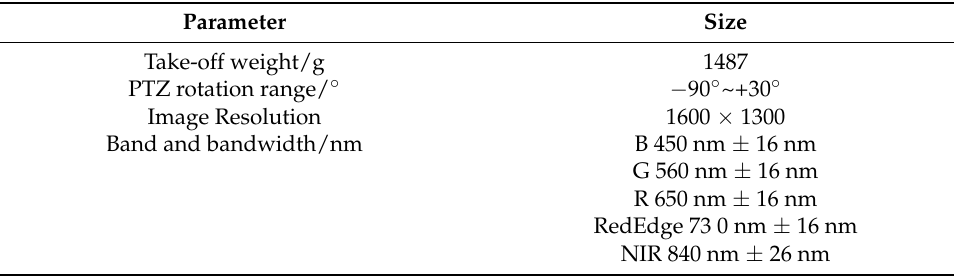
Table 1. The parameters of the multispectral UAV.